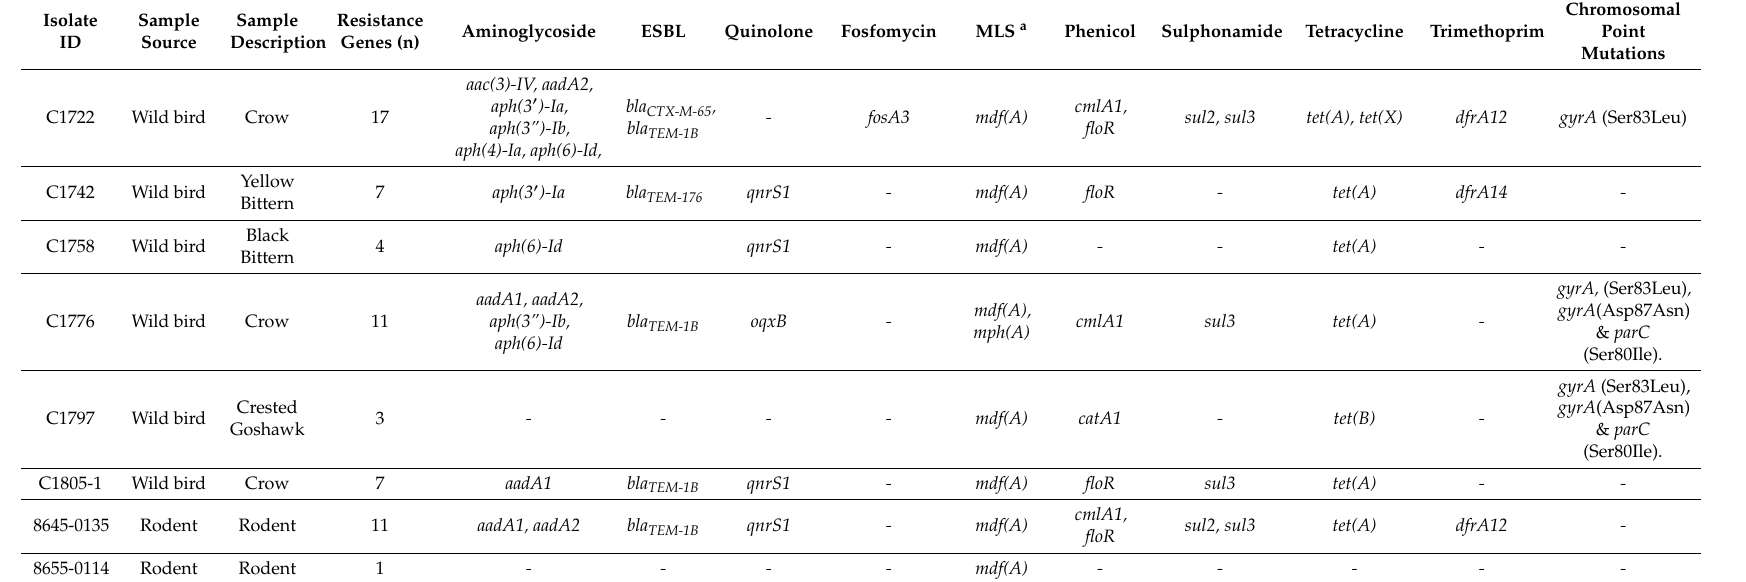
Table 5. Distribution of resistance genes in the eight multi-drug resistant E. coli